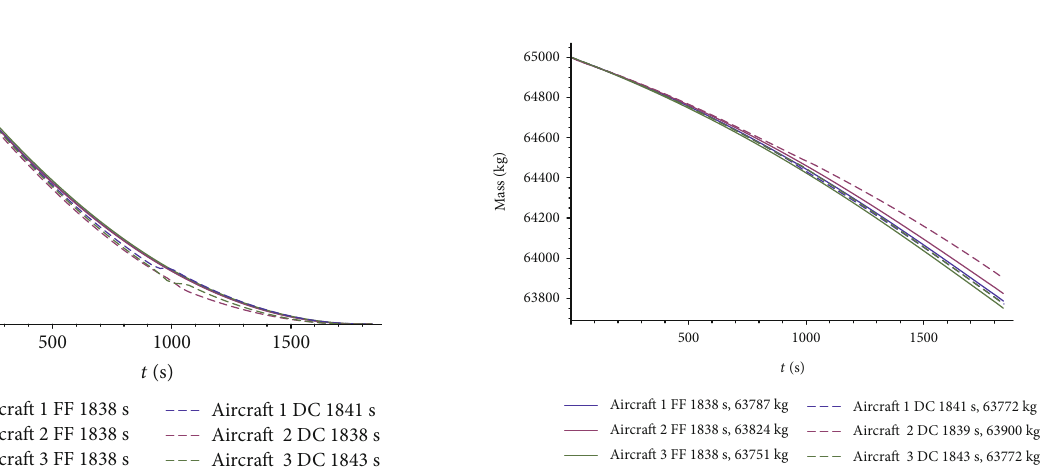
Figure 12: Experiment 2. Mass consumption with (DC, dashed lines) and without (FF, solid lines) distance-based separation constraints. Table 6: Results of Experiment